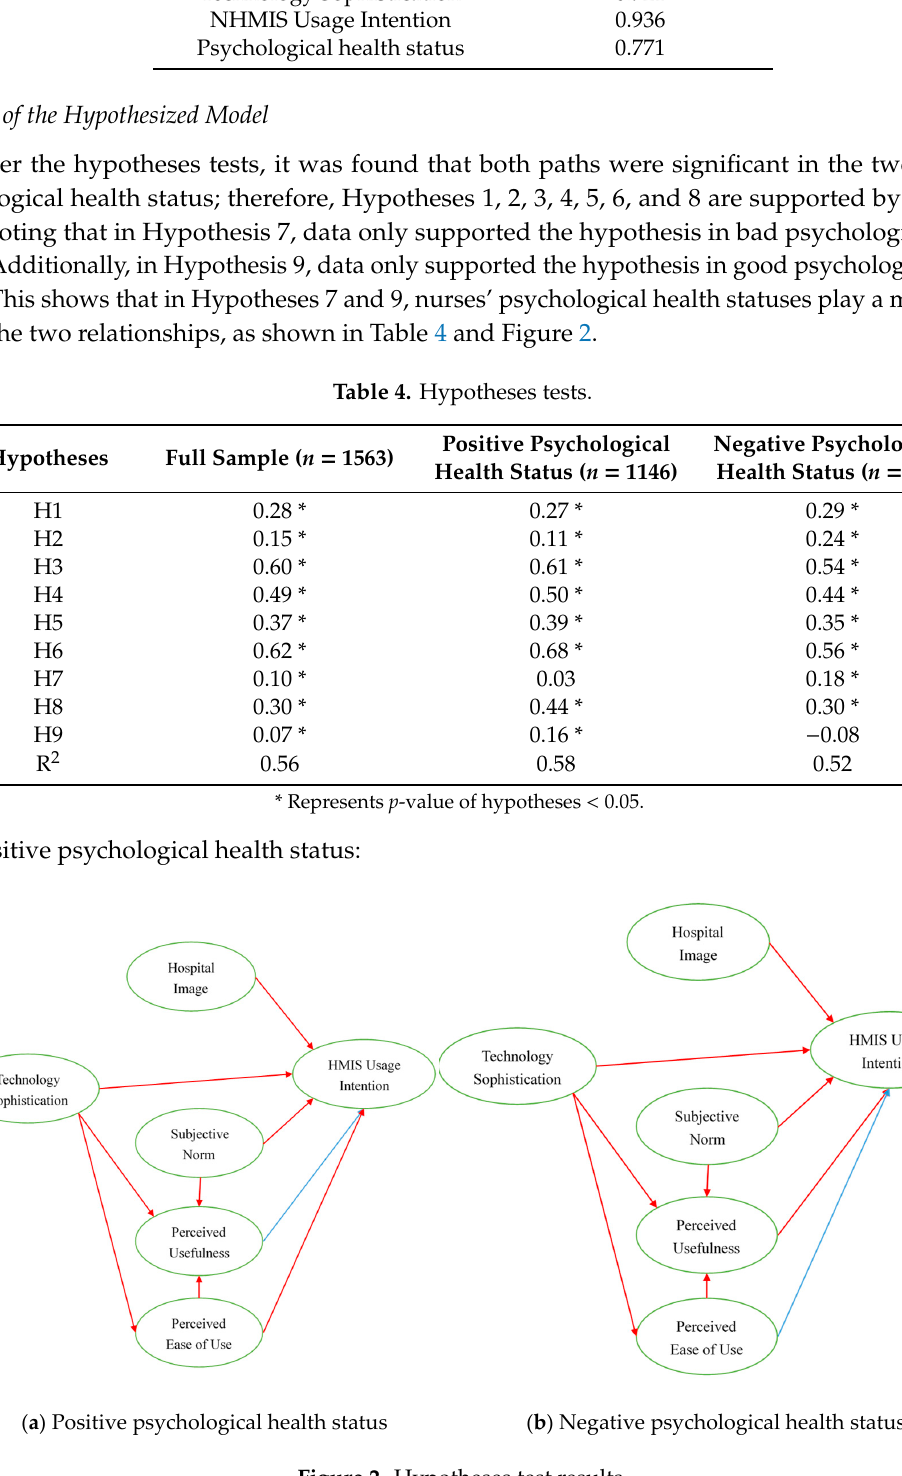
Figure 2. Hypotheses test results.